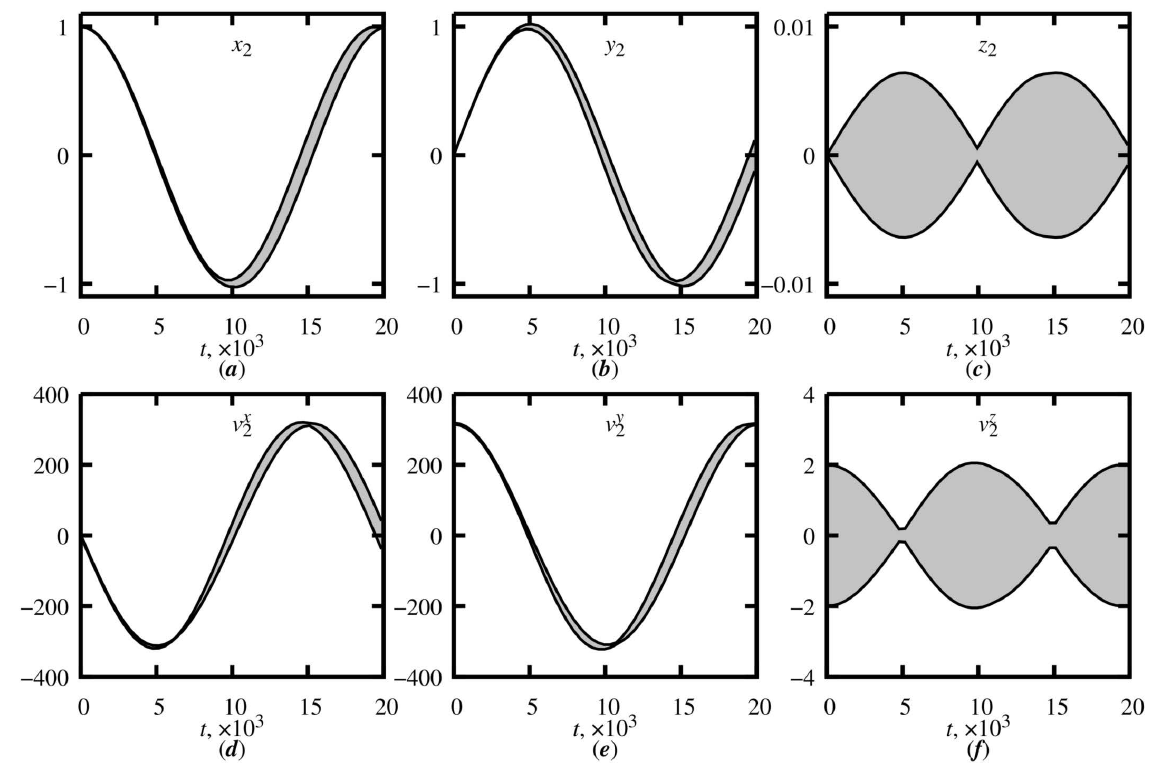
Figure 13. Time dependencies of upper and lower estimates of the 2nd body coordinates and velocities: ( a ) x 2 ( t ) ; ( b ) y 2 ( t ) ; ( t ) ; ( e ) v y ( t ) ; ( f ) v z ( t ) ( c ) z 2 ( t ) ; ( d ) v x 2 2 2